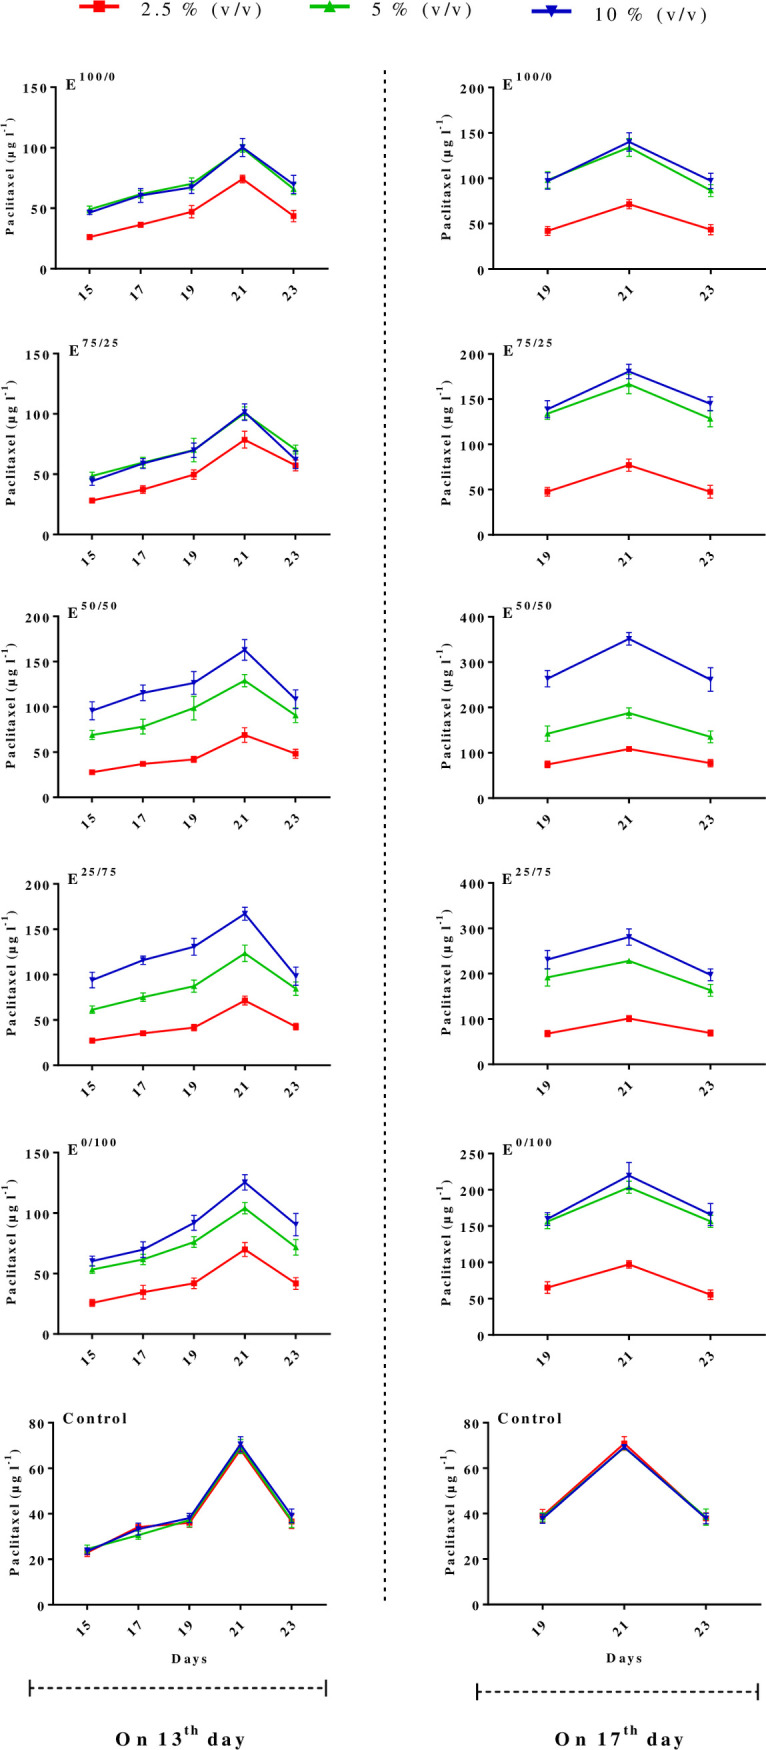
Time course of paclitaxel biosynthesis in Corylus avellana cell cultures exposed with 2.5, 5 and 10% (v/v) of cell extract (CE) and/or culture filtrate (CF) derived from Camarosporomyces flavigenus on 13th and 17th days of cell culture cycle.E100/0; 100CE:0CF, E75/25; 75CE:25CF, E50/50; 50CE:50CF, E25/75; 25CE:75CF, E0/100; 0CE:100CF.